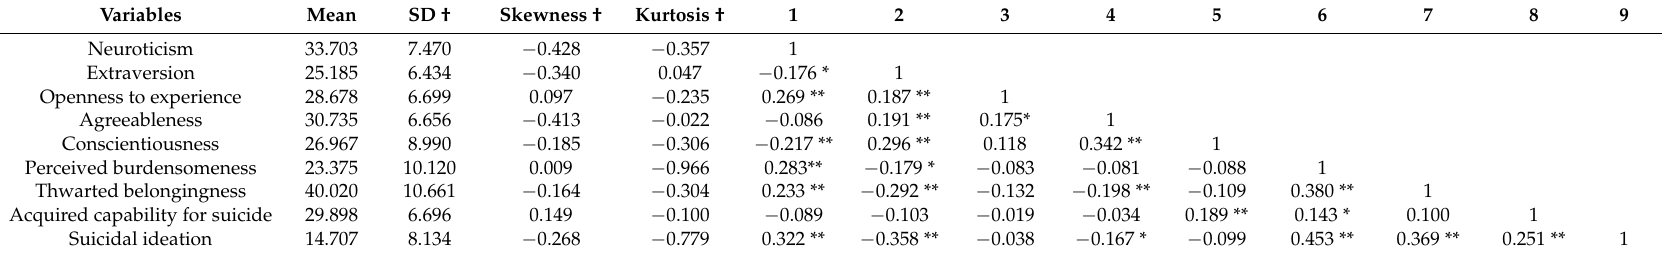
Table 1. Means, standard deviations and bivariate Pearson’s correlation matrix for variables of interest ( n = 201 with five